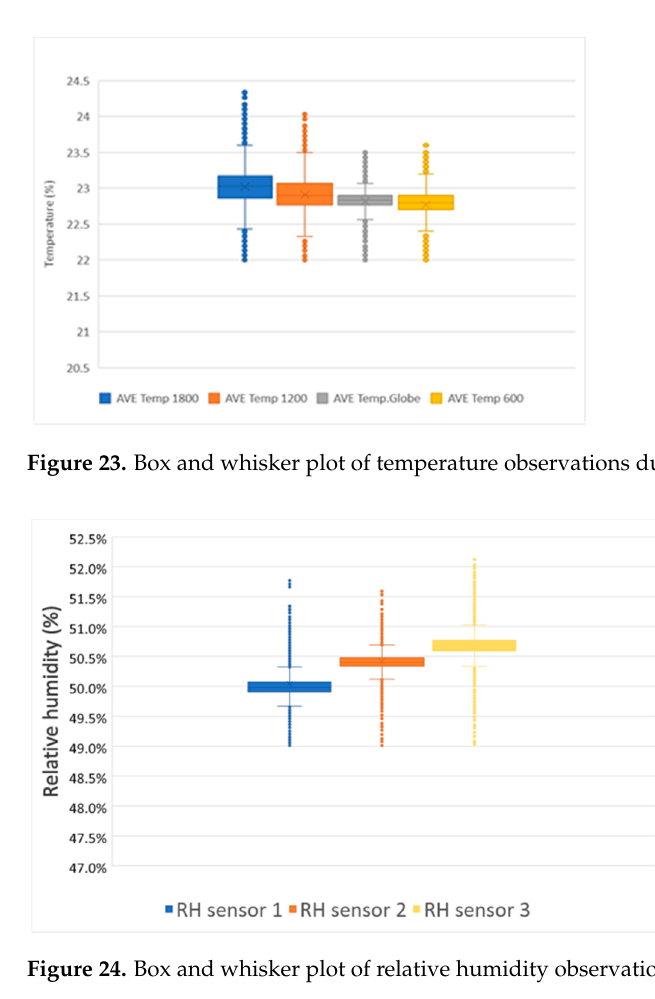
Figure 22. Relative humidity profile of the room aimed at 50% for the testing period 2.